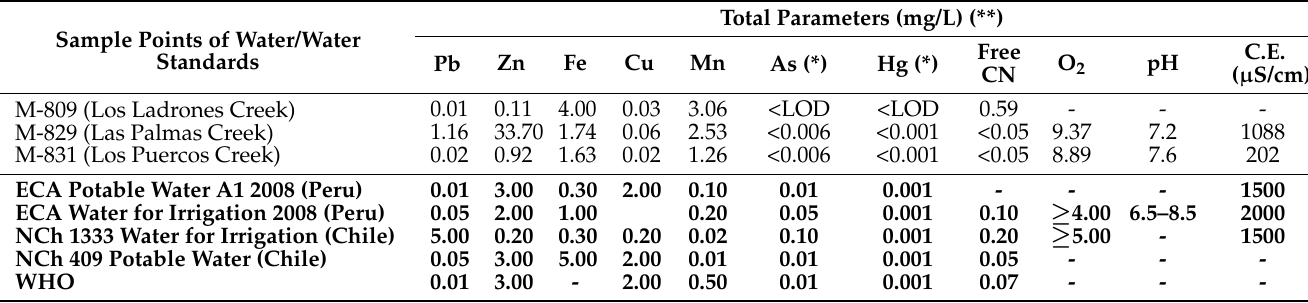
Table 6. Results of Chemical Analysis of Water Samples compared with Water Standards